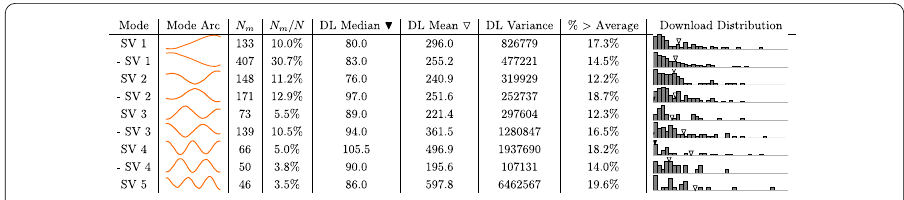
Figure 7 Download statistics for stories whose SVD Modes comprise more than 2.5% of books, for N the total number of books and N m the number corresponding to the particular mode. Modes SV 3 through - SV 4 (both polarities of modes 3 and 4) exhibit a higher average number of downloads and more variance than the others. Mode arcs are rows of V T and the download distribution is show in log 10 space from 20 to 30,000